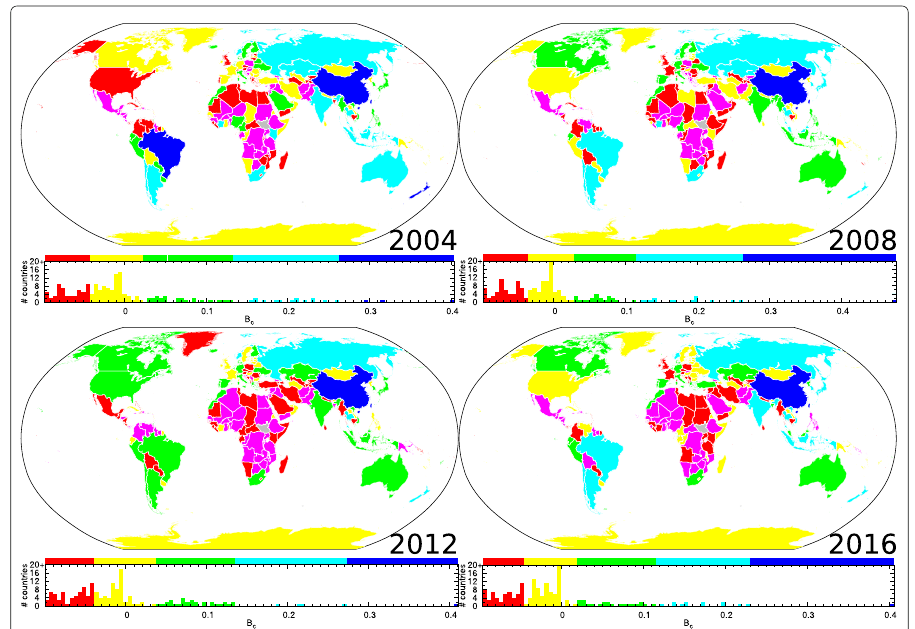
Fig. 5 Geographical distribution of the PageRank-CheiRank trade balance B c at the contagion stage τ = 0 with the bankruptcy threshold κ = 0.1. For each year, at the contagion stage τ = 0, the countries colored in red (blue) have the most negative (positive) balance B c > − κ . Color categories are obtained using the Jenks natural breaks classification method (Wikipedia contributors 2020). Countries going to bankruptcy at contagion steps τ = 0 are colored in magenta. The damping factor is α =